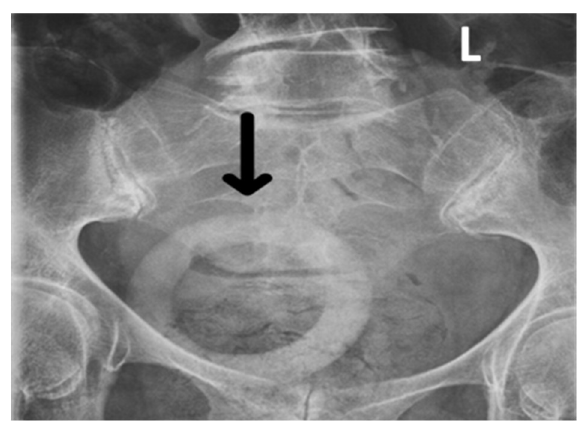
Figure 3. Antero-Posterior View of Pelvic Radiograph Showing Displaced Ring Pessary (Represented by Black